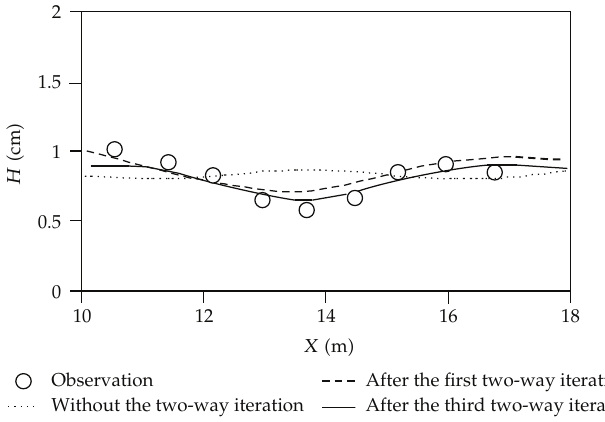
Figure 8: Comparison of the observed and the calculated wave heights along line x (cid:9) 12 .